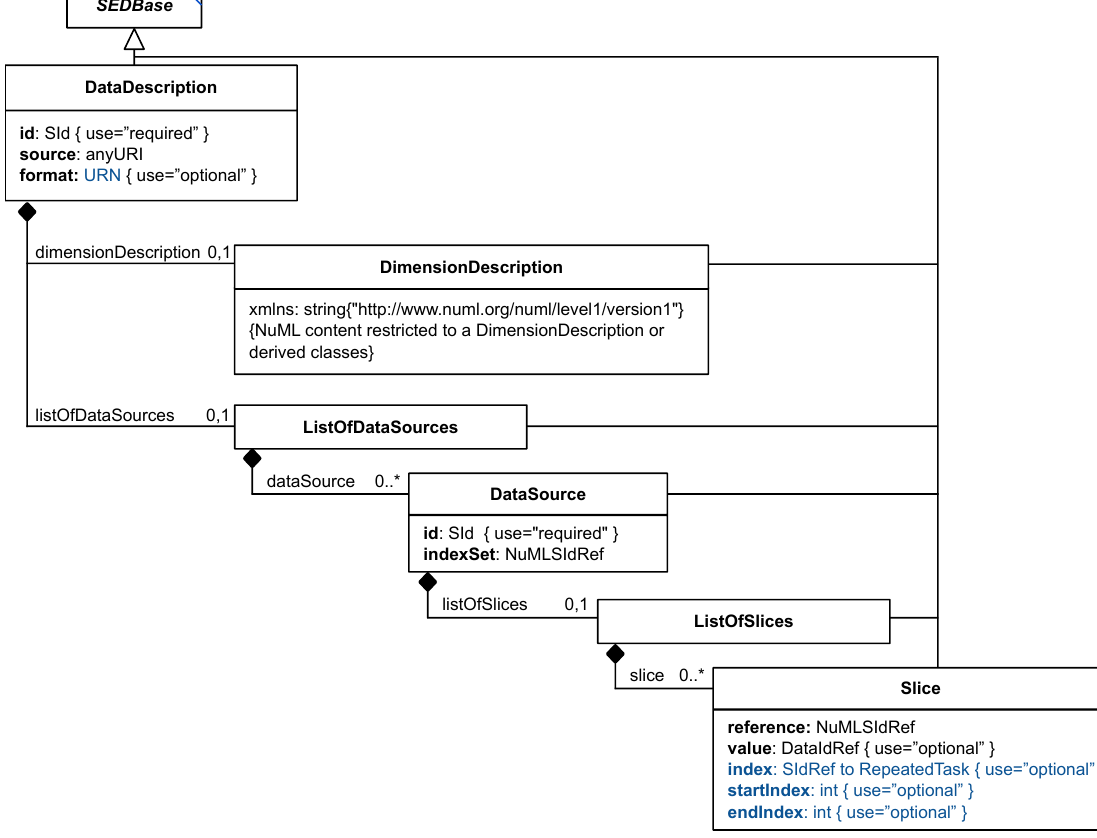
Figure 2.8: The SED-ML DataDescription